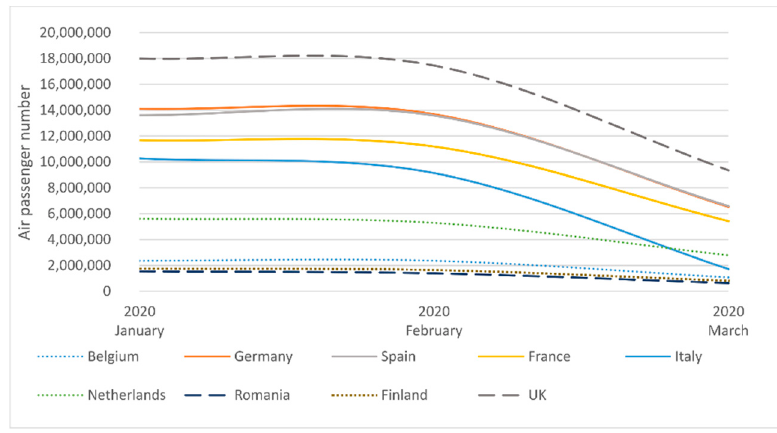
Figure 14. Number of air passengers for the January 2020–March 2020 period.